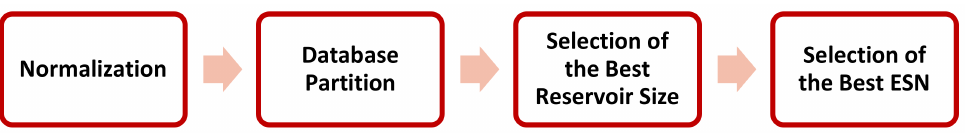
Figure 9. Development process for the WTESN